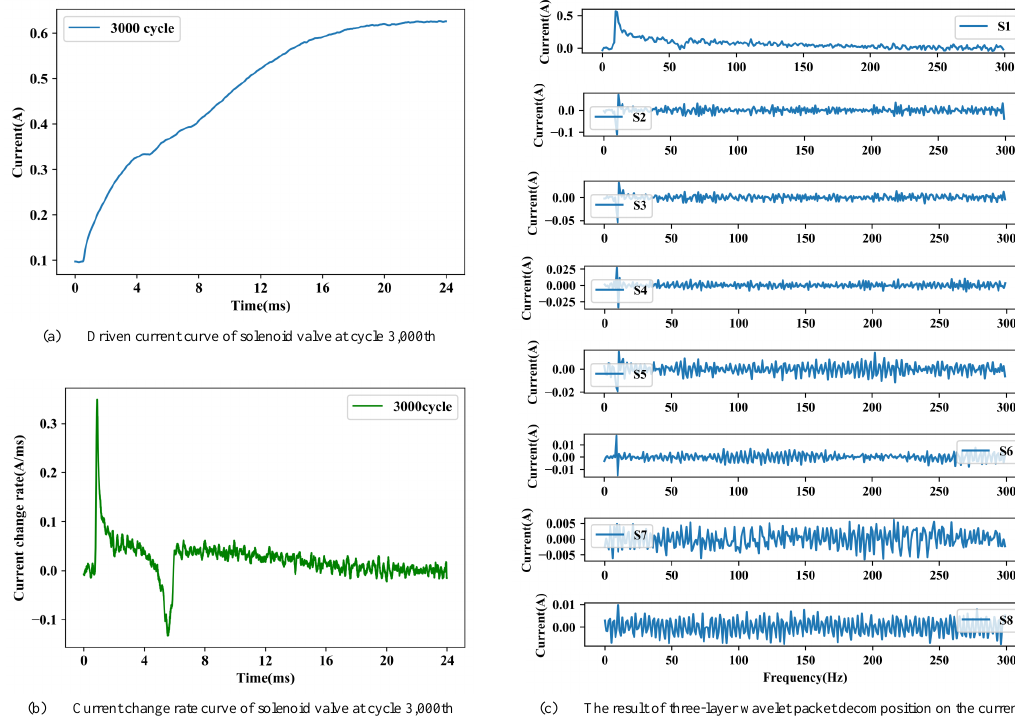
Figure 6. Results of feature extraction by wavelet packet decomposition on the current change rate curve of the high-speed solenoid valve: ( a ) Driven current curve of the solenoid valve on the 3000th cycle; ( b ) current change rate curve of the solenoid valve on the 3000th cycle; and ( c ) the result of three-layer wavelet packet decomposition on the current change rate curve of the solenoid valve on the 3000th